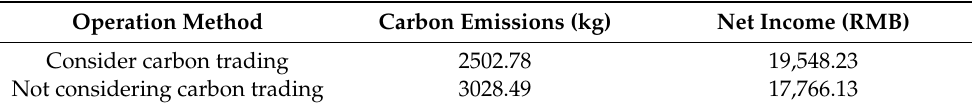
Table 6. Peak and valley tariffs for non-summer commercial and other electricity consumption in